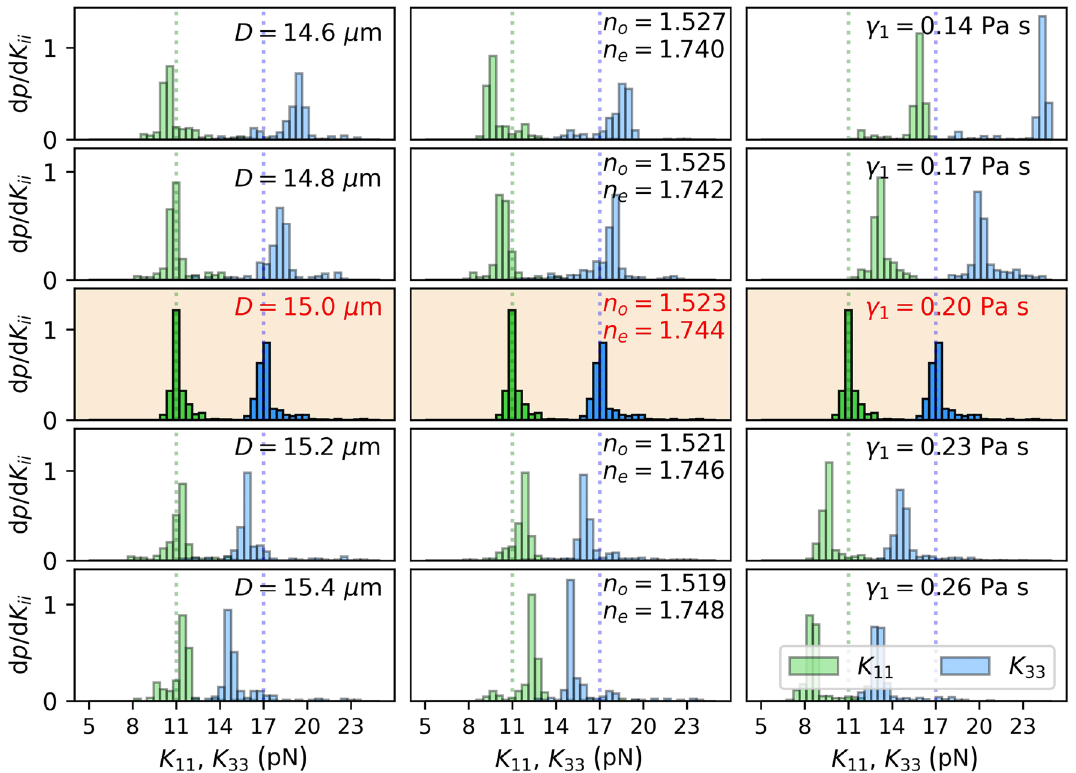
Figure 4. Sensitivity of the method for determining K 11 and K 33 to the inaccuracy of parameters used to generate the training data. The neural network that predicts K 11 and K 33 from I ( t ) is trained on data from simulations with D = 15 µ m , γ 1 = 0.200 Pa s, n o = 1.523 , and n e = 1.744 . If the neural network is used to predict elastic constants of a sample with actual constants K 11 = 11 pN , K 33 = 17 pN and exactly the same parameters ( D , γ 1 , n o , n e ), good quality of prediction is